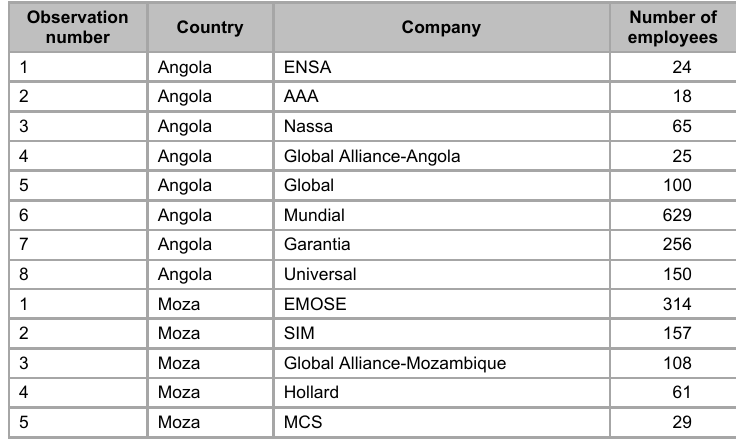
Mean values for the sample